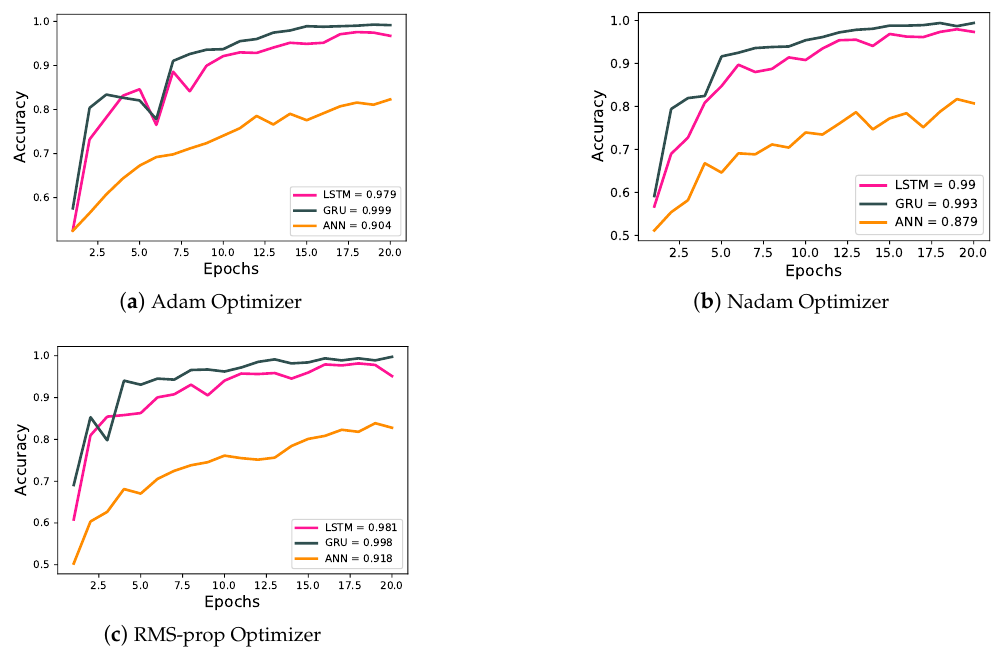
Figure 7. Comparison of LSTM, GRU, ANN training accuracy with different optimizers.